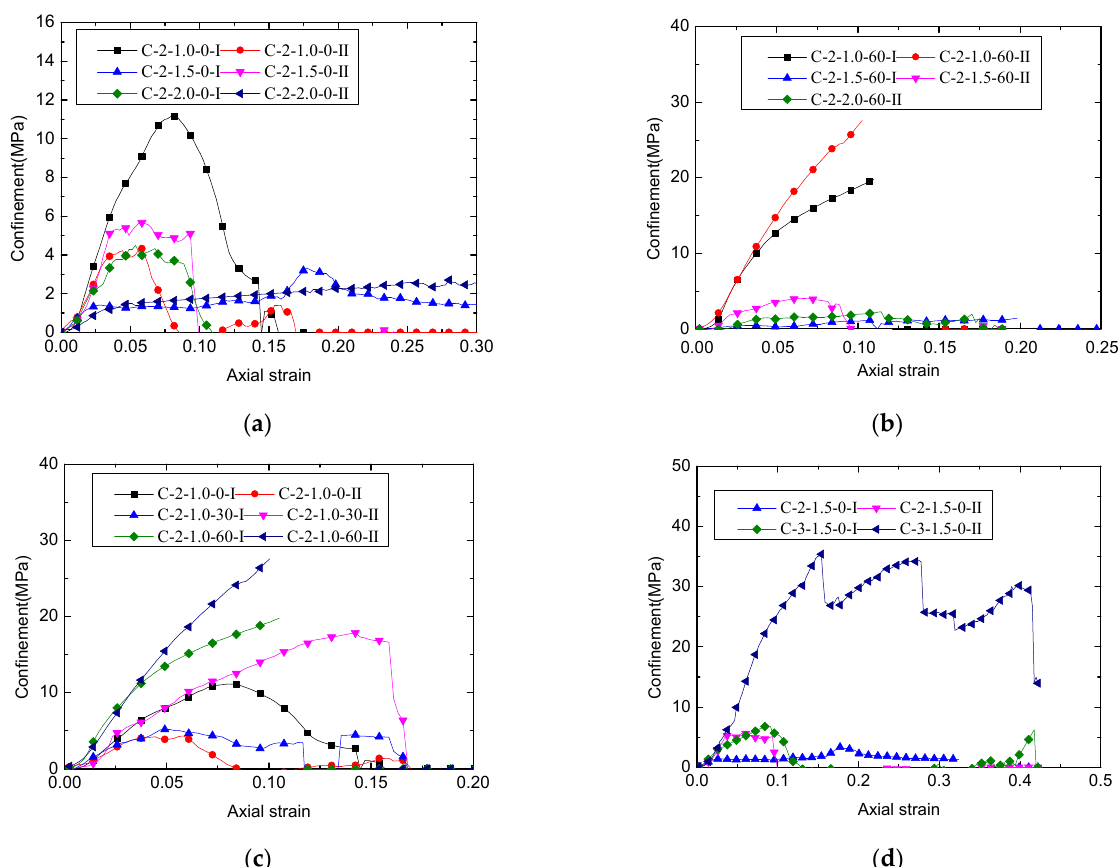
( b ) Figure 12. Material consumption of CSBM specimens: ( a ) the mixing amounts of cementing material with varying ratios of water to powder cement (1.0, 1.5, and 2.0); ( b ) the mixing amounts of water with varying ratios of water to powder cement (1.0, 1.5, and 2.0). 4. Confining Action of CFRP Composite on SBM 4.1. Calculation of the Confining Pressure The CFRP tube in the CSBM specimen interacted radially with SBM. Consequently, the CFRP tube was less likely to buckle and had a higher strength. Moreover, the presence of the CFRP tube altered the expansion features of SBM. As per above, there are already many studies concerning FRP-confined circular concrete columns. The standard constitu-